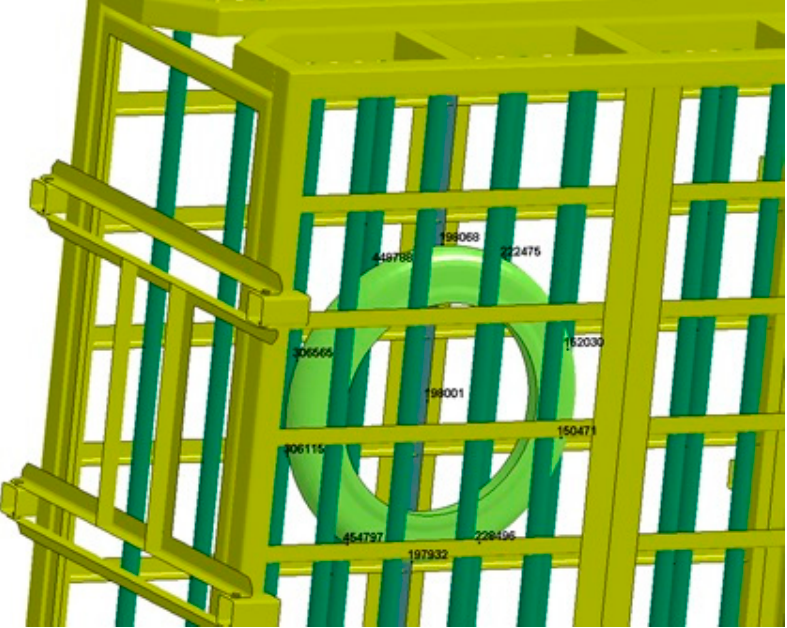
Figure 10. Selected points of the protective shield structure—impact in the middle of the cage.